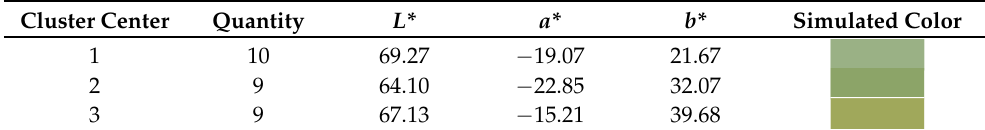
Table 4. The color center of yellow-green opal.